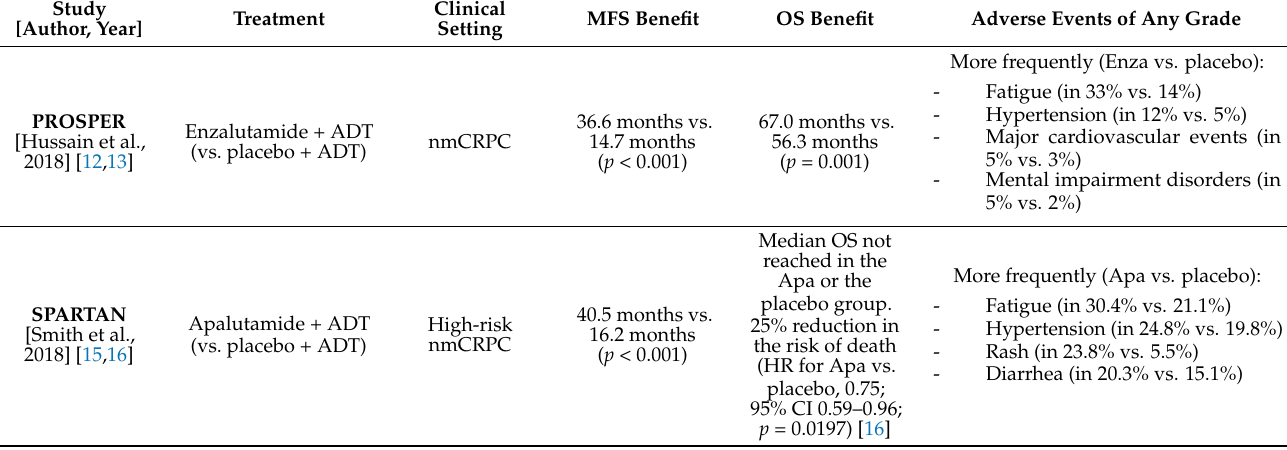
Table 1. Recently presented or published phase III clinical trials assessing novel ARSIs in nonmetastatic castration-resistant